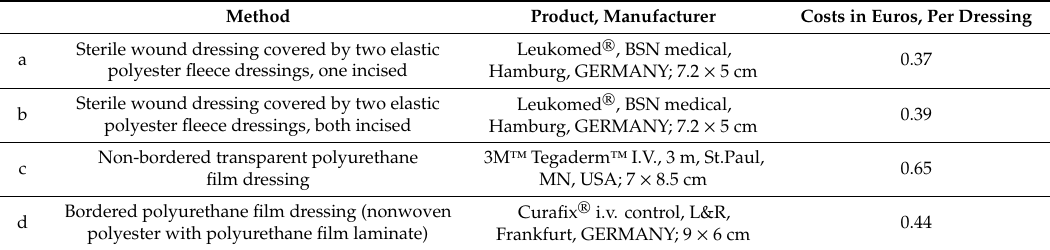
Figure 6. Dislodgement forces of four securements: a, sterile wound dressing covered by two elastic polyester fleece dressings, one incised; b, sterile wound dressing covered by two elastic polyester fleece dressings, both incised; c, non-bordered transparent polyurethane film dressing; d, bordered polyurethane film dressing (nonwoven polyester with polyurethane film laminate). Box plots indicate medians, interquartile range 25–75 and range without outliers (whiskers). Circles show outliers. ** = p < 0.01, *** = p < 0.001. Table 2. Costs of four